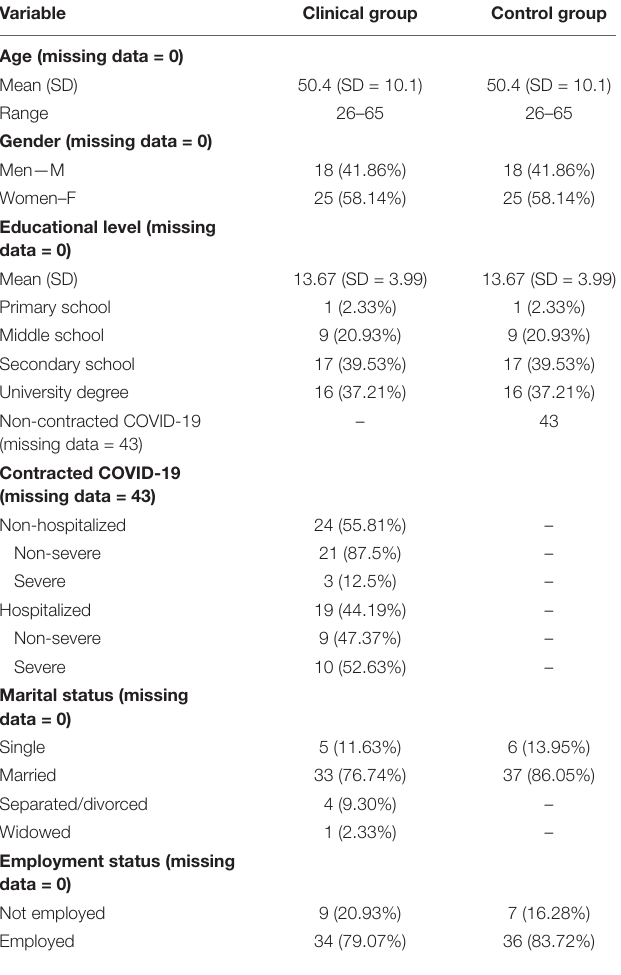
TABLE 1 | Sociodemographic variables characterizing the clinical group and the control